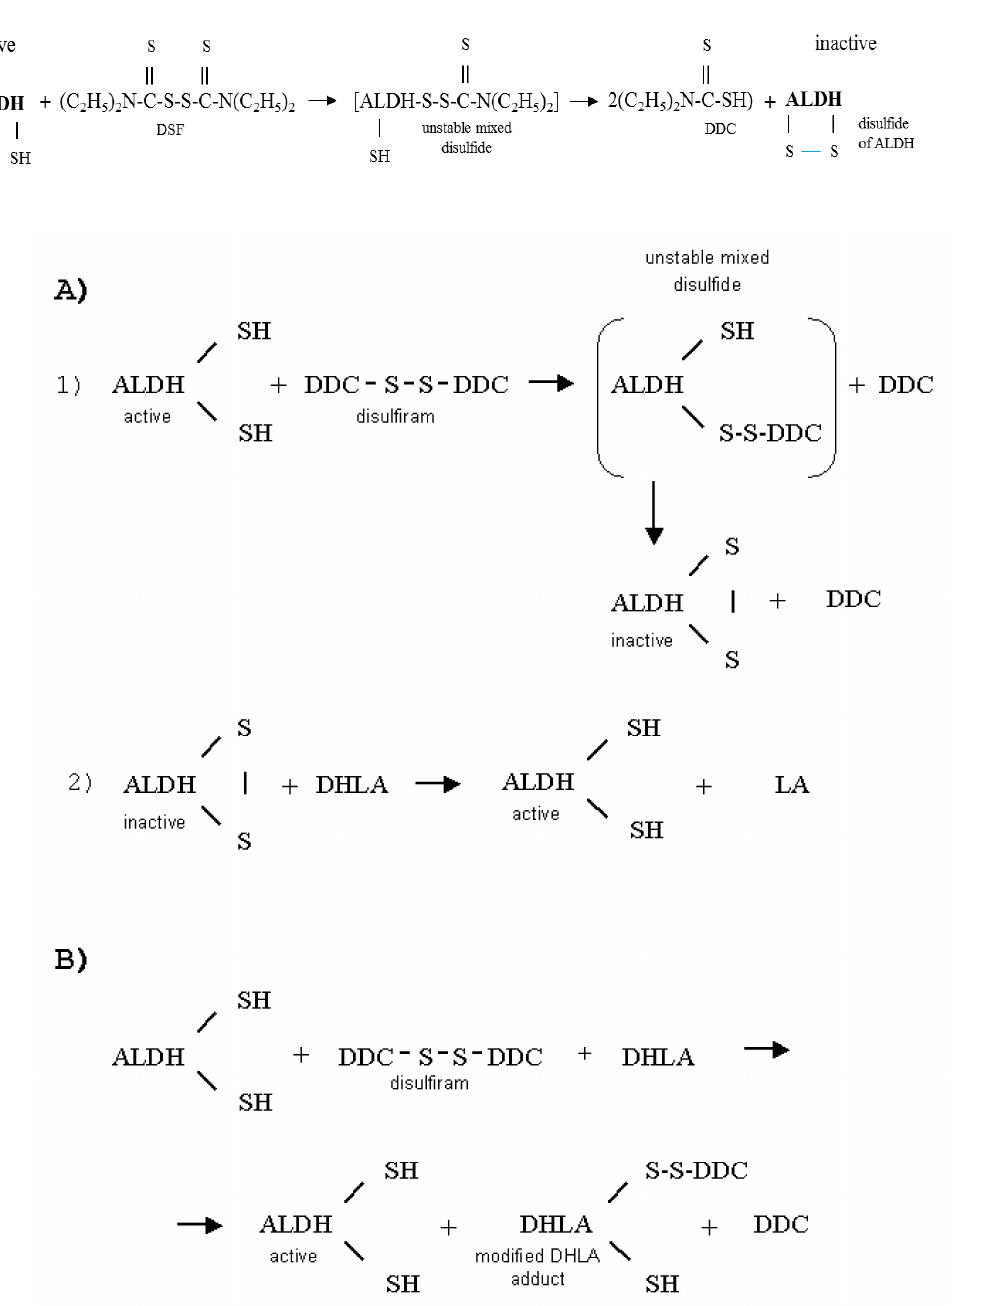
Figure 7. A proposed mechanism of the interaction between ALDH, DSF, and DHLA. DHLA is able both to restore and protect ALDH activity blocked by DSF in vitro. ( A ) The activity of ALDH, oxidatively inhibited by DSF (A1) was restored by DHLA (A2). ( B ) In the presence of DHLA, DSF does not react with